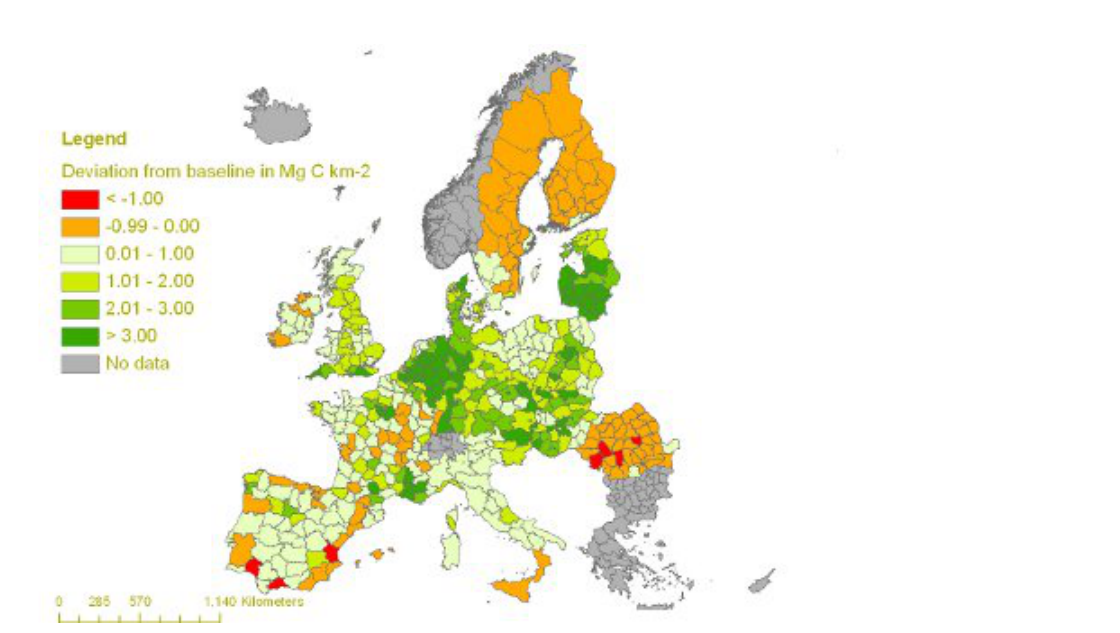
Fig. 7 . Common Agricultural Policy financial reform scenario: 100% cut of Common Agricultural Policy first pillar measures (market support and direct income support), and re-investment of savings in research and development. The map shows impacts on carbon sequestration (Mg C km -2 ), and proportional changes with respect to the reference scenario for the year